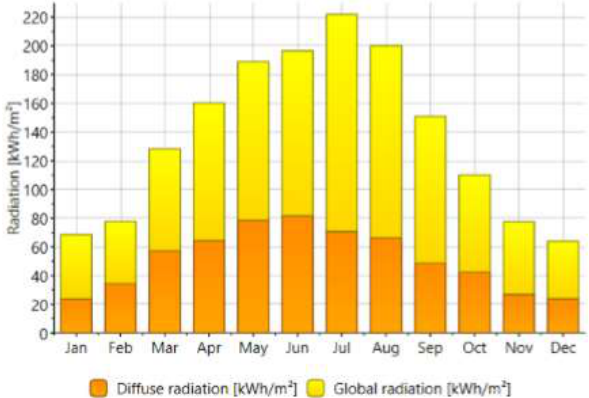
Figure 3. The monthly diffuse and global solar radiation values for the city of